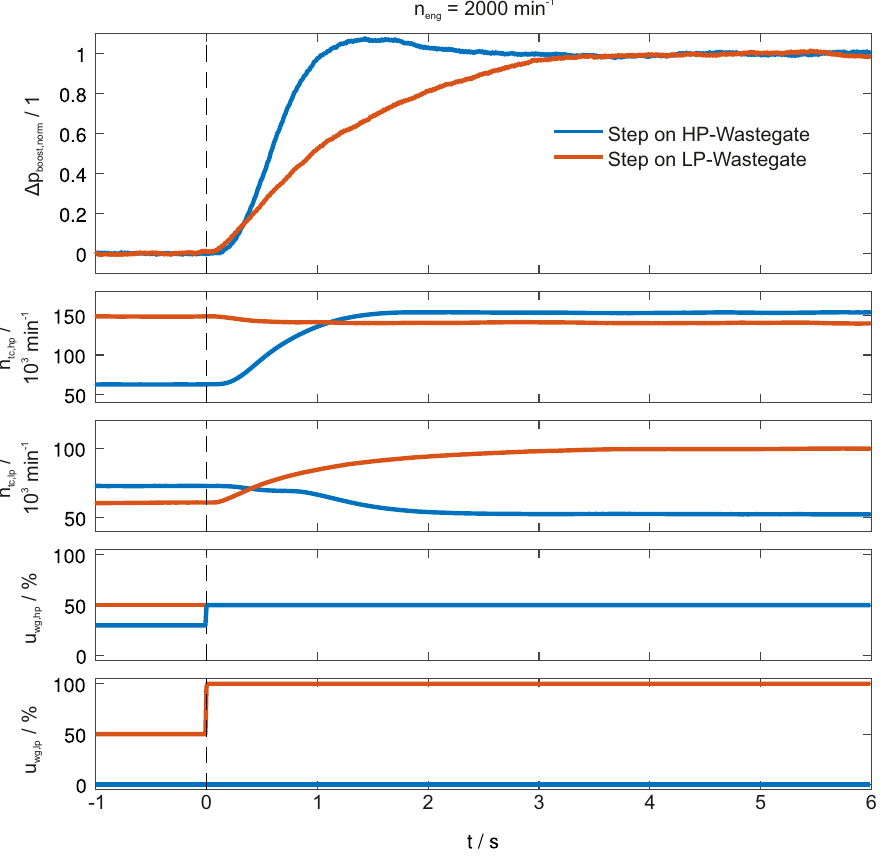
Figure 4. Comparison of transient behavior for the step input on low pressure wastegate u lp , wg and on high pressure wastegate u hp , wg